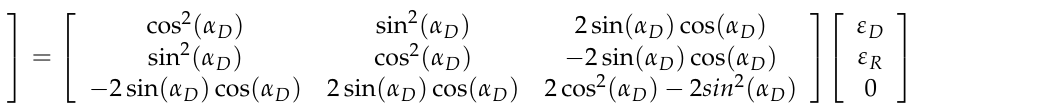
Figure 2. Principal directions and principal stresses. By using a similar transformation law, the average normal and shear strain compo- nents in the L-T reference frame ( ε L , ε T and γ LT , respectively) can be related in a matrix form with the principal strains ( ε R and ε D ) and the variable angle α D as